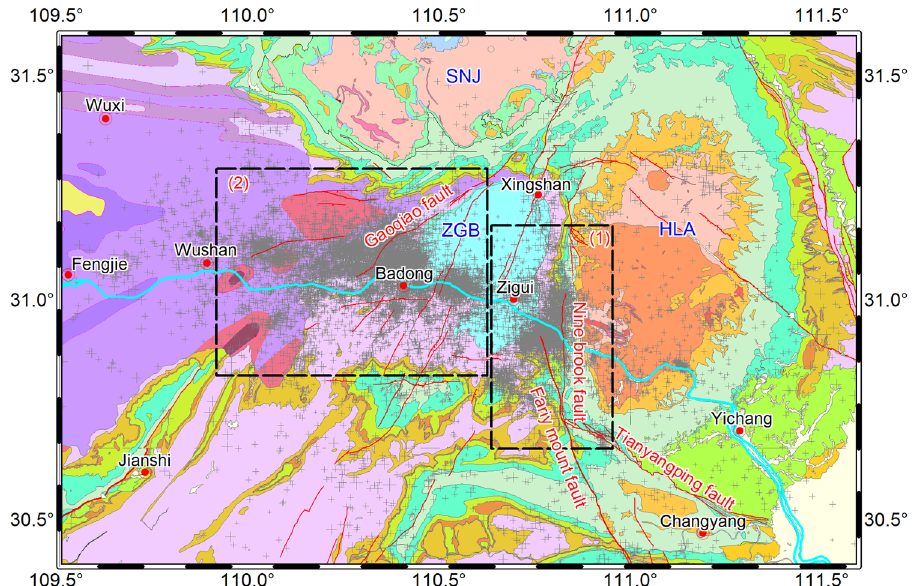
Figure 1. Geological structural map of the head area of the Three Gorges Reservoir. Huangling anticline (HLA), Zigui basin (ZGB), and Shennongjia block (SNJ) are the main tectonic units in the Three Gorges Reservoir area. The black dashed boxes represent the Badong earthquake swarm and the Zigui earthquake swarms, the gray dots represent the distribution of earthquakes since 2003, and red lines represent faults. The map was created using the free software GMT (http:// mirro rs. ustc. edu. cn/